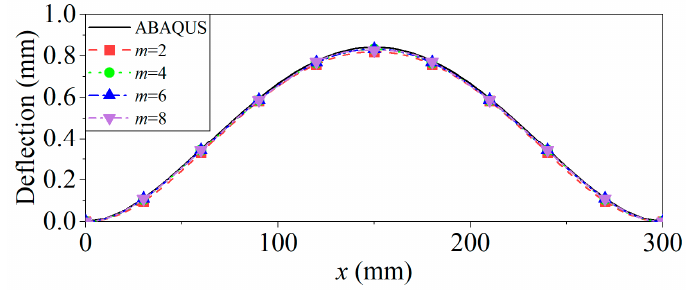
are utilized, consisting of 30 elements and 31 nodes, with the “Nlgeom” option enabled during static analysis. A pressure load of 0.25 N/mm is used. The results are displayed in Figure 2, with ‘ m ’ representing the number of assumed shape solutions. The analysis results exhibit close agreement with those obtained from ABAQUS, which gradually converge as more assumed solutions are considered. Following the convergence analysis, the proposed method adopts sixth-order shape functions for estimating deflection to ensure higher computational efficiency while maintaining accuracy.